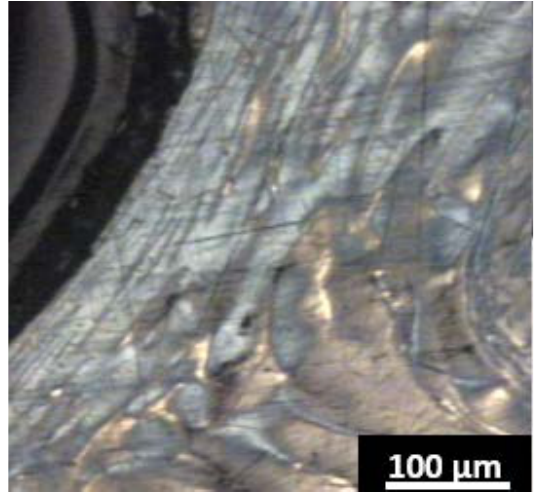
Figure 4. Polarized light micrograph of co-carbonized anthracene-fluorene.